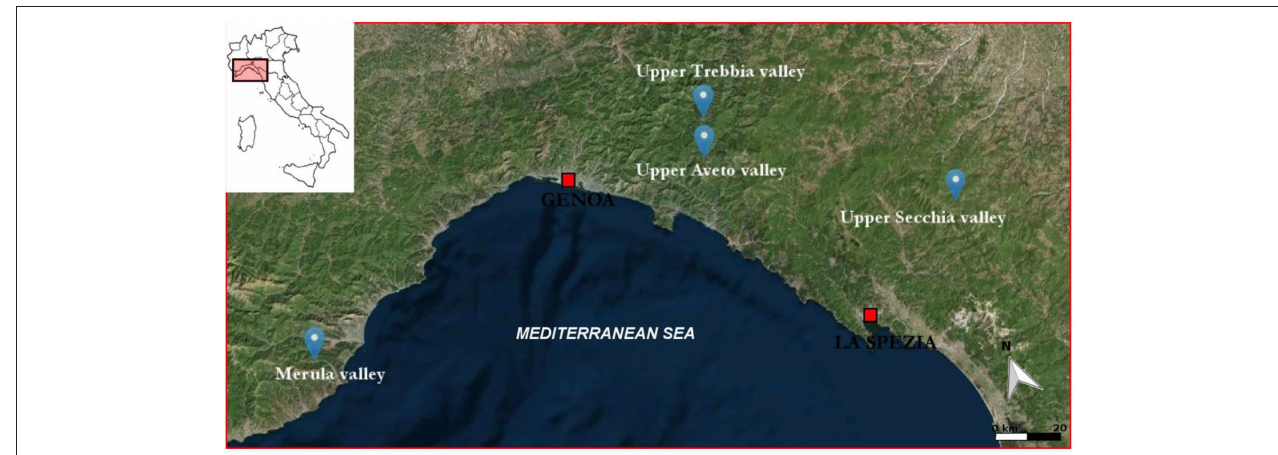
FIGURE 1 | Localities and case studies cited in the